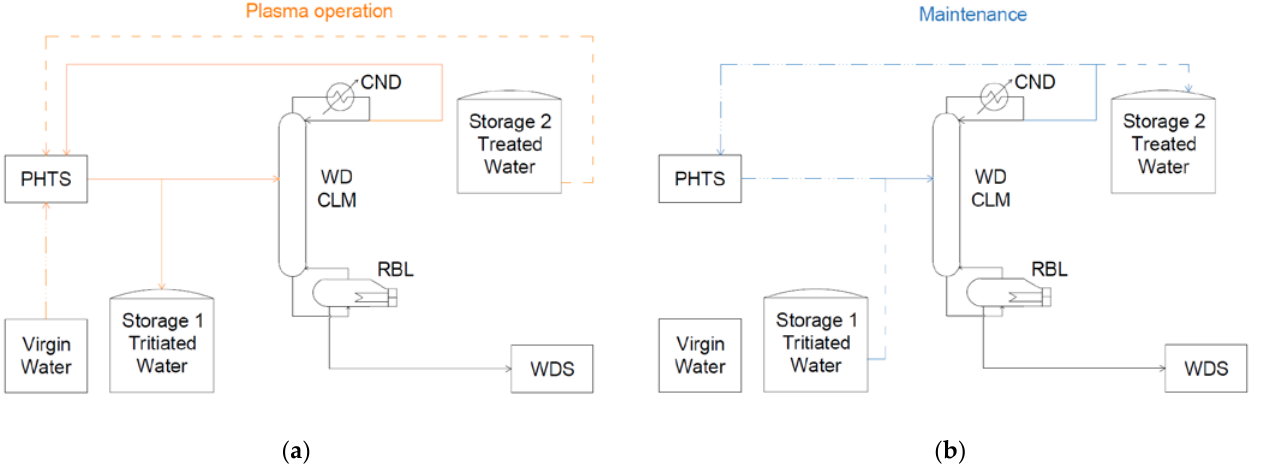
Figure 6. The water CPS full hybrid strategy: ( a ) flow diagram during plasma operation; ( b ) flow diagram during maintenance.